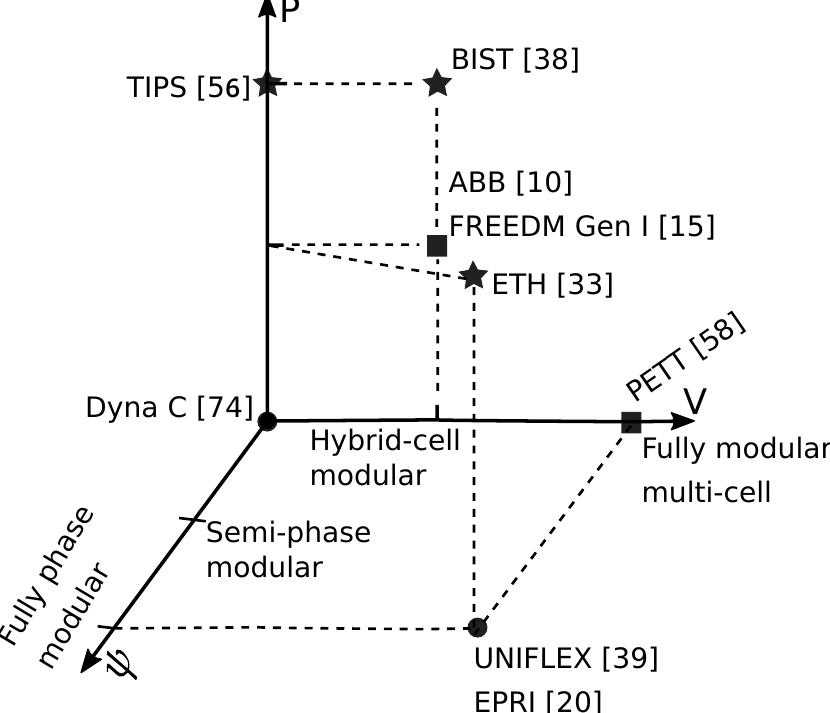
Figure 19. Modularity defined in PV ψ plane: